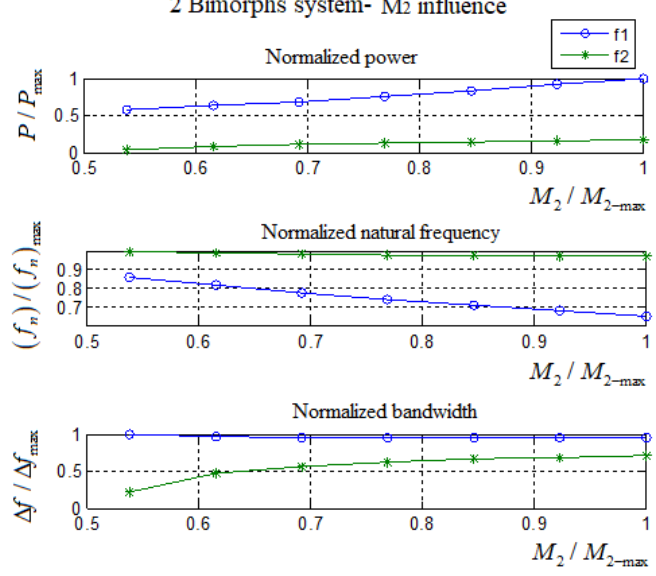
Figure A5. The influence of the normalized M 2 mass on the output power, the natural frequencies, and the bandwidth (all normalized)—two bimorphs interconnected by a spring case.